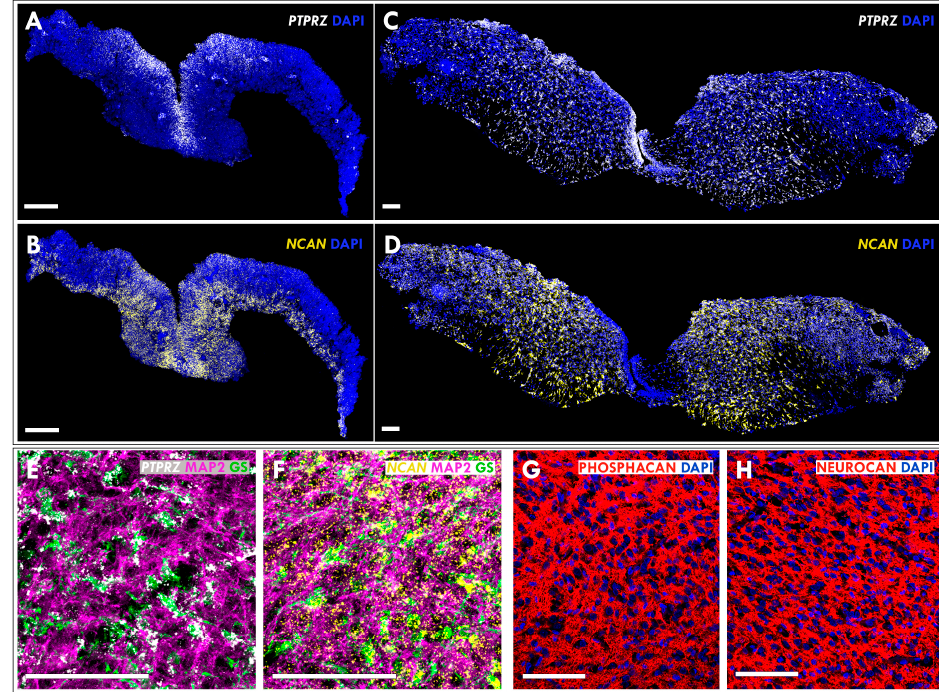
Figure 4. ( A – D ) Using RNAscope technology localization of PTPRZ/Phosphacan (white) and Neurocan (yellow), expression was demonstrated in spinal cord sections from MMC defects examined at E14 ( A , B ) and E21 ( C , D ). Cell nuclei were fluorescently stained with DAPI (blue). ( E , F ) The type of cells that synthetize RTPRZ/Phosphacan and Neurocan were identified by coimmunostaining for glutamine synthetase (GS; green), a marker of astrocytic cells; MAP2 (magenta), a marker of neurons; and RNAscope for PTPRZ/Phosphacan (white; ( E )); or Neurocan (yellow; ( F )) in spinal cord sections from MMC defects examined at E21. ( G , H ) The extracellular expression pattern of neurocan and phosphacan proteins was demonstrated by immunostaining of spinal cord sections from the MMC defect examined at E21. Neurocan and phosphacan immunostainings (red) are shown in combination with DAPI (blue). Scale bar indicates 100 µm. Data represent at least three sections from three fetuses per age group.